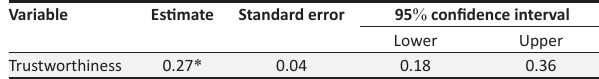
error ratio TABLE 4: Indirect effect of propensity on